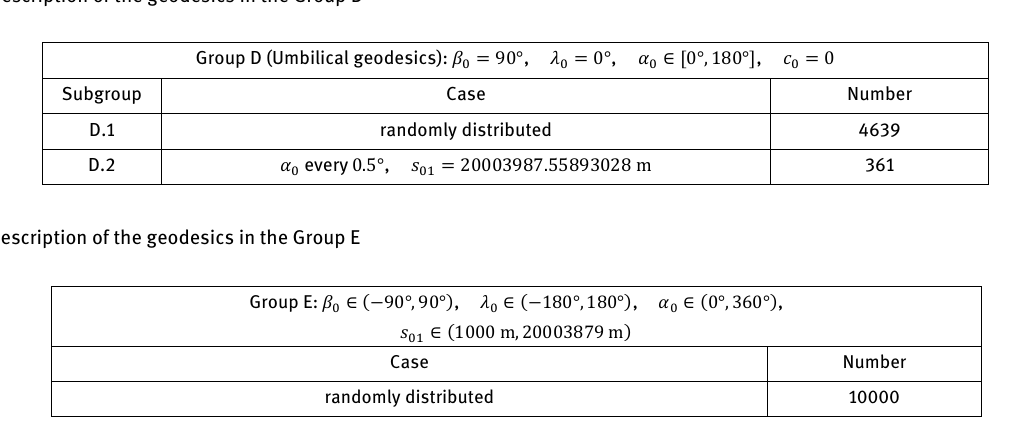
Table 8: Description of the geodesics in the Group D